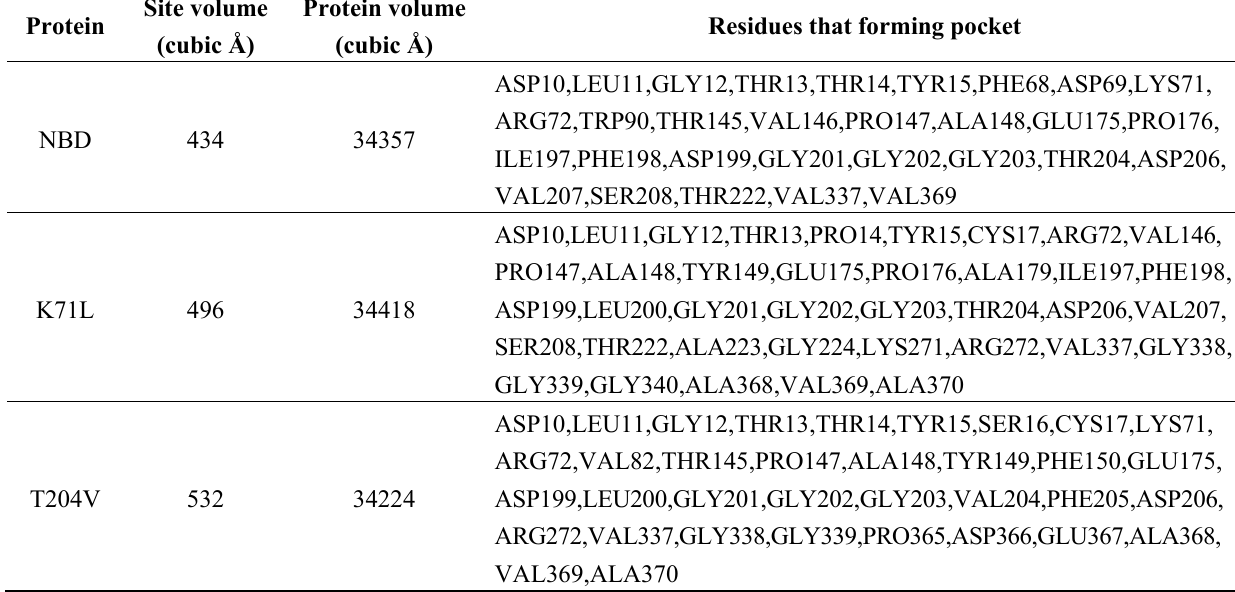
Table 4. Predicted active sites of the NBD protein, K71L and T204V mutants. Protein